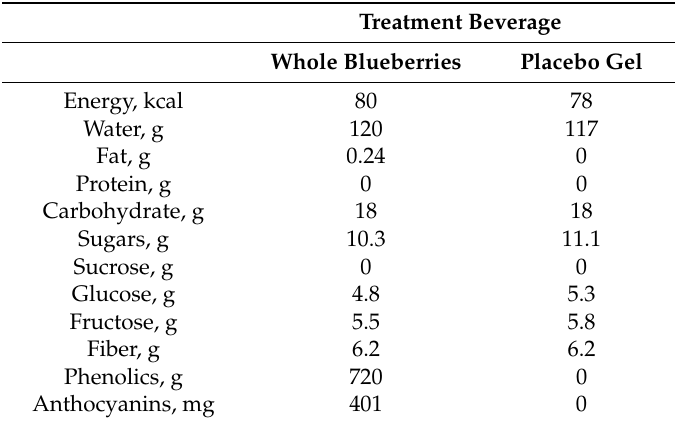
Table 1. Nutrient composition of whole blueberries and placebo gel treatment 1